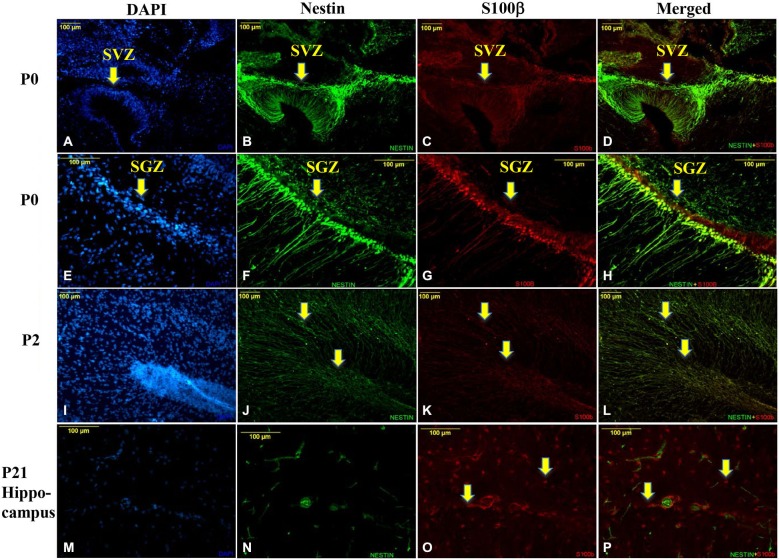
S100β labels the progenitors both at SVZ and SGZ around birth and is re-expressed in mature astrocytes. Dual immunofluorescence labeling with Nestin (green; B,F,J,N) and S100β (red; C,G,K,O). The expression of both the markers coincided completely in the radial fibers and progenitors at SVZ (D) and SGZ (H) around birth. At P2 the stem astrocytes forming glial tubes (arrows) were labeled for both Nestin and S100β (L). Mature astrocytes loose Nestin and express S100β only (O). In merged image at P30 (P) no S100β labeled astrocytes co-expressed Nestin. DAPI (blue) clearly indicated the brain areas focused (A,E,I,M).